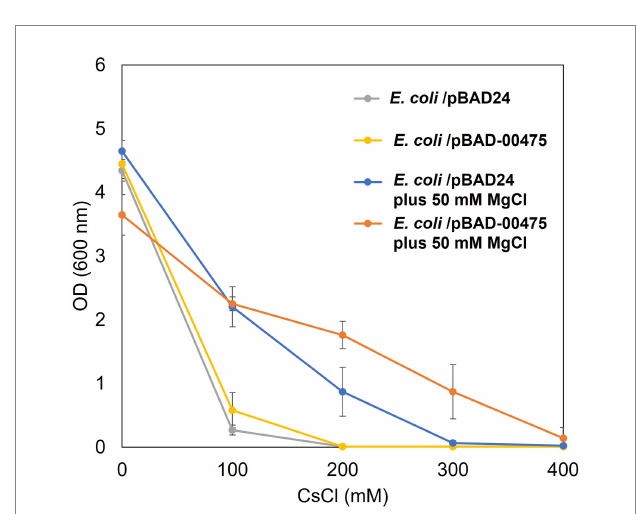
FIGURE 6 Cs + resistance growth test on Escherichia coli KNabc harboring pBAD- 00475 in the presence of Mg 2+ . Turbidity (OD 600 ) of E. coli KNabc/ pBAD-00475 in LBK medium and E. coli KNabc/pBAD-00475 in LBK medium plus 50 mM MgCl 2 at each CsCl concentration and after 16 h of culturing. Error bars indicate SD for three independent experiments. E. coli KNabc/pBAD24 was used as the negative